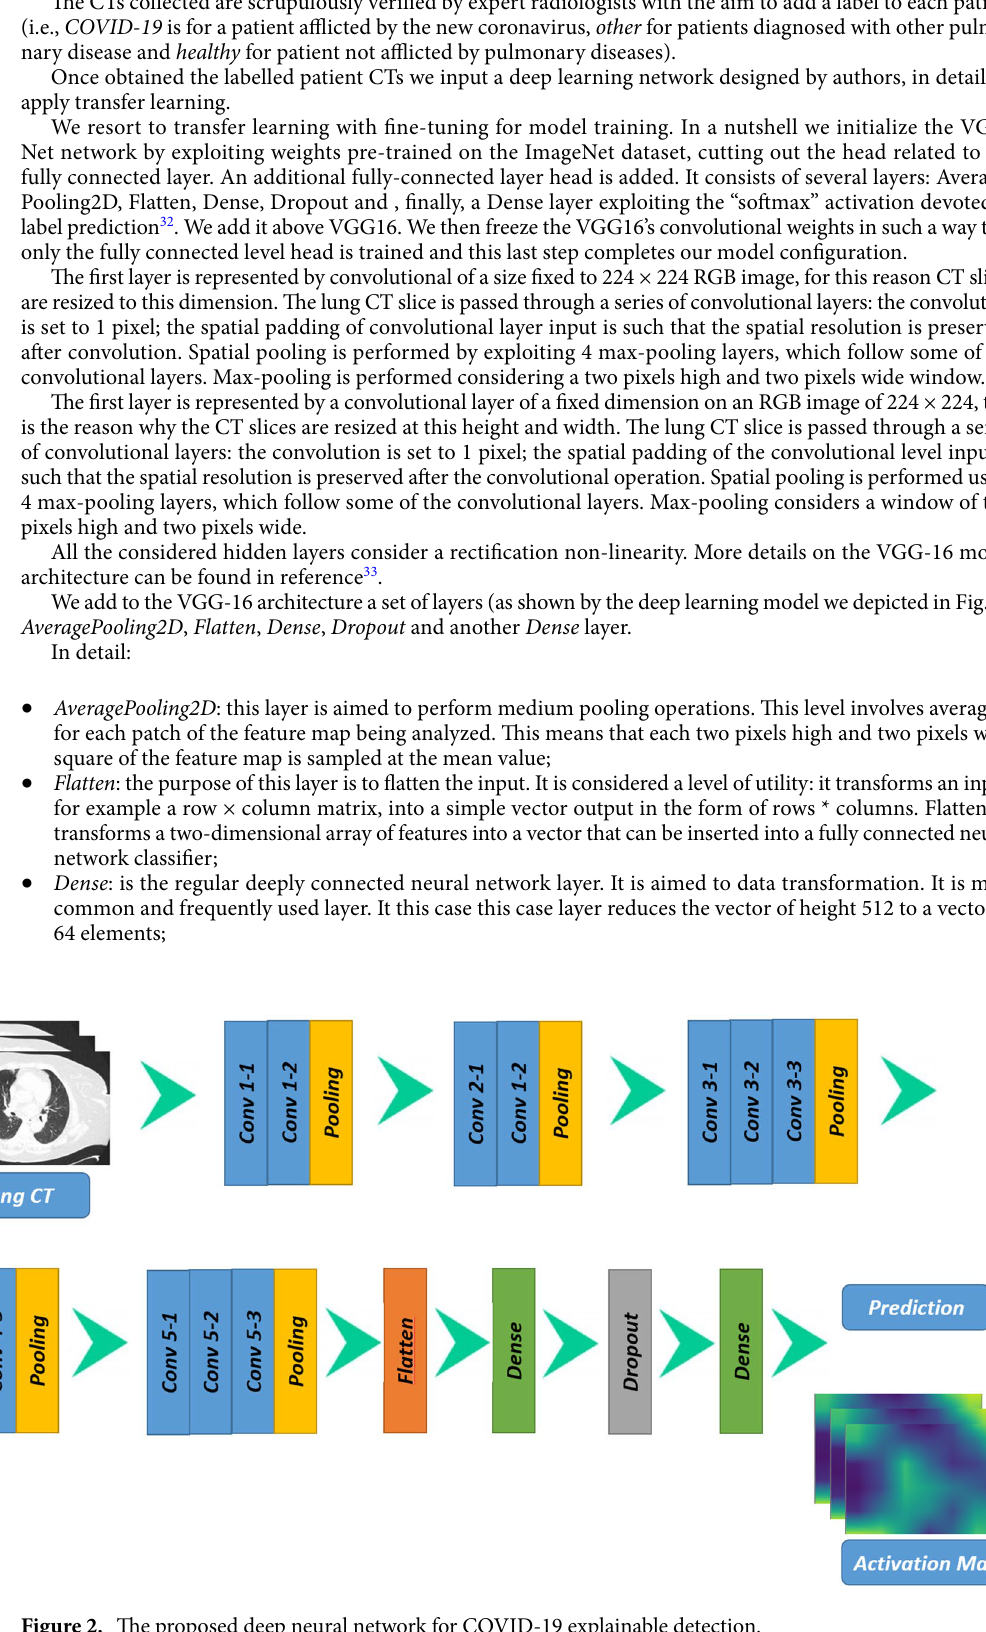
Figure 2. The proposed deep neural network for COVID-19 explainable